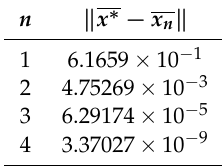
Table 4. Newton–Kurchatov method